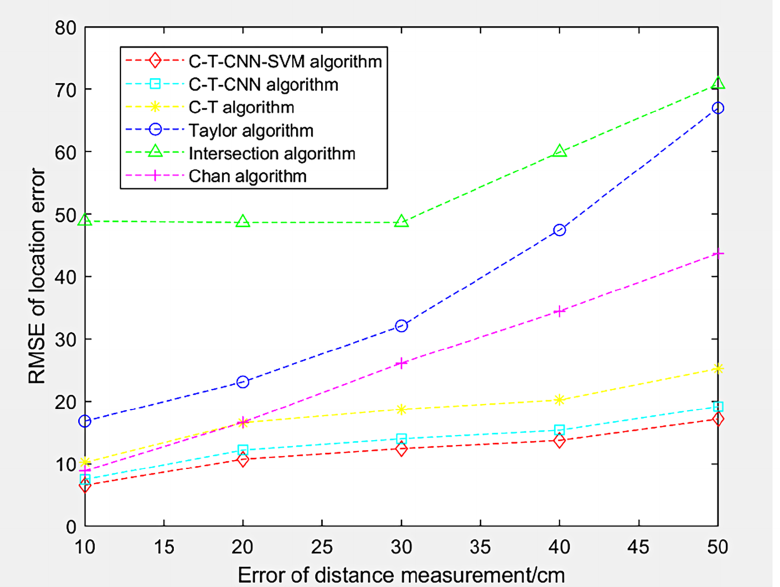
Figure 19. Relation curve between root-mean-square distribution and location error of each